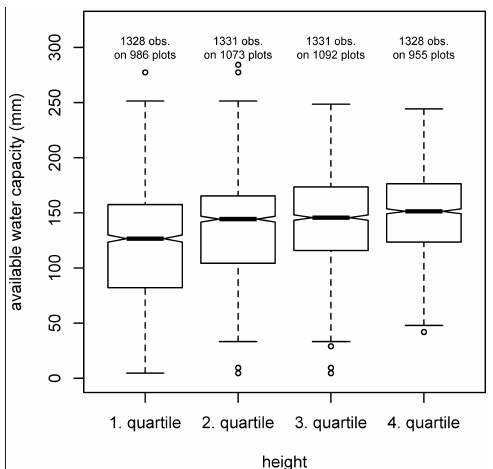
Figure 3. Boxplot of AWC for the quartiles of scaled height distribution; differences in means are